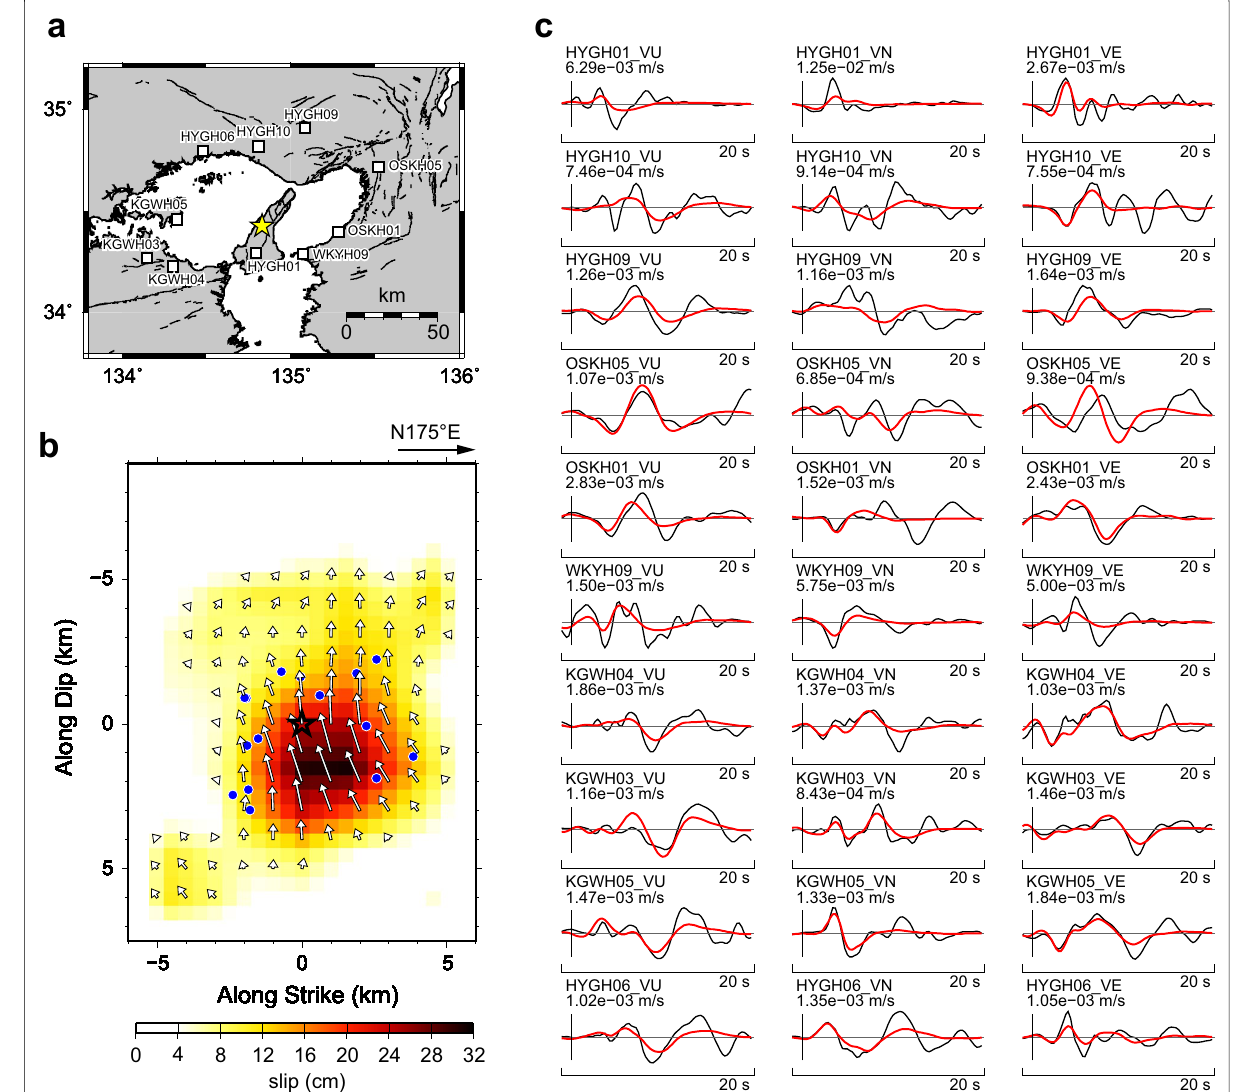
Fig. 15 Results of slip inversion. a Distribution of strong-motion stations (KiK-net) used for slip inversion. A yellow star indicates the hypocenter of the mainshock. b Slip distribution of the 2013 Awaji Island earthquake inferred from the inversion of strong-motion records. The arrows show slip vectors of the hanging wall. A star shows the hypocenter of the mainshock. Blue circles correspond to on-fault aftershocks. c Observed (black) and synthetic waveforms (red) from the estimated source